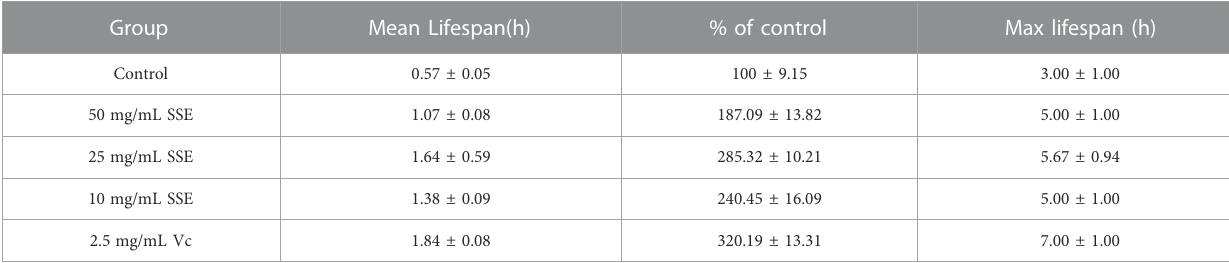
TABLE 3 Effects of SSE on the oxidant treatment responses of Caenorhabditis elegans (mean ± SD, n = 3). Group Mean